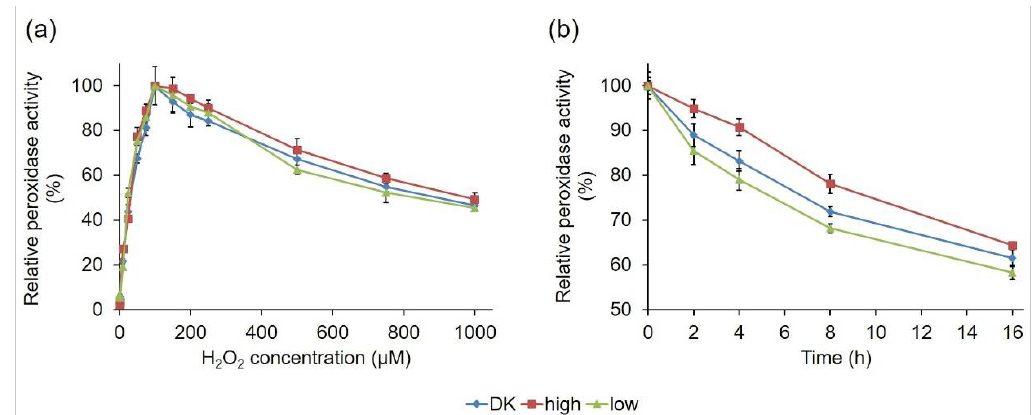
Figure 9. Effect of hydrogen peroxide concentration on the activity of the PsaPOX variants ( a ), and relative peroxidase activity of the PsaPOX variants during biotransformation of trans -anethole over 16 h ( b ). Relative peroxidase activity was defined as the percentage of activity detected normalized to the highest activity ( a ) or to the starting activity ( b ) of the corresponding enzyme variant in each experiment. Values are the average of triplicate experiments with standard deviations shown as error bars. DK: PsaPOX_DK; high: PsaPOX_high; low: PsaPOX_low.